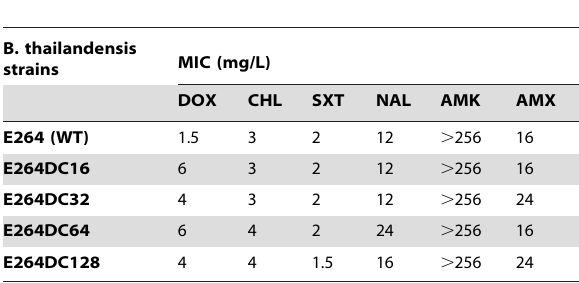
Table 6. Antibiotic susceptibility of the B. thailandensis strains after plating eight times on medium without